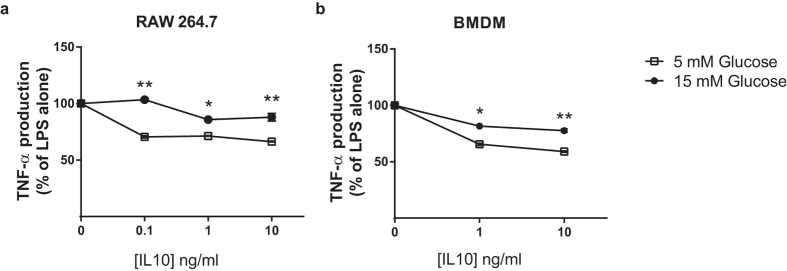
RAW264.7 cells and BMDMs (bone marrow-derived macrophages) grown in 15 mM glucose are hyporesponsive to IL10.RAW264.7 cells (a) and BMDMs (b) were cultured for six hours in 9% FCS in DMEM containing either 5 mM or 15 mM glucose. Cells were then stimulated for two hours with 1 ng/mL LPS in the presence of 0–10 ng/mL of IL10, and supernatants collected for TNF-α production (expressed as % of that induced by LPS alone) by ELISA. Values are mean ± SEM (N = 3). *p < 0.05 & **p < 0.001 vs. 5 mM glucose condition.